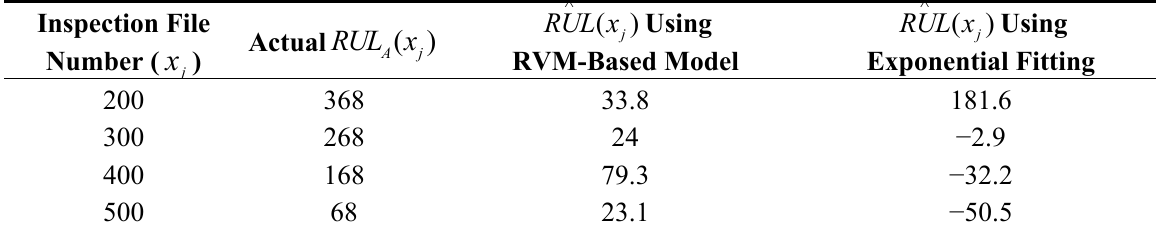
 using the RVM-based model and exponential fitting. RUL x j